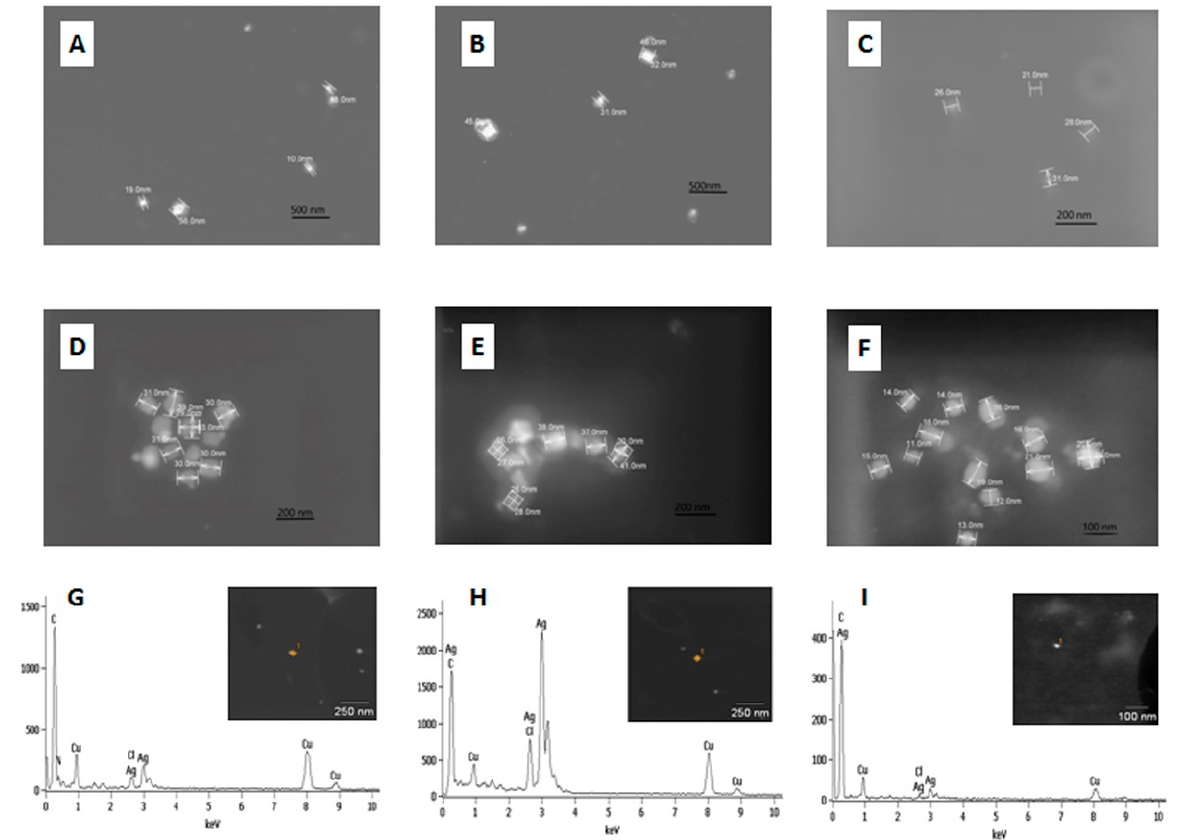
Figure 2. STEM images of AgLTF complexes with marked particle sizes: ( A ) AgLTF30; ( B ) AgLTF45; ( C ) AgLTF120; ( D ) AgLTF450; ( E ) AgLTF900; ( F ) and STEM-EDX spectra of samples: ( G ) AgLTF30, ( H ) AgLTF45, ( I ) AgLTF1200.